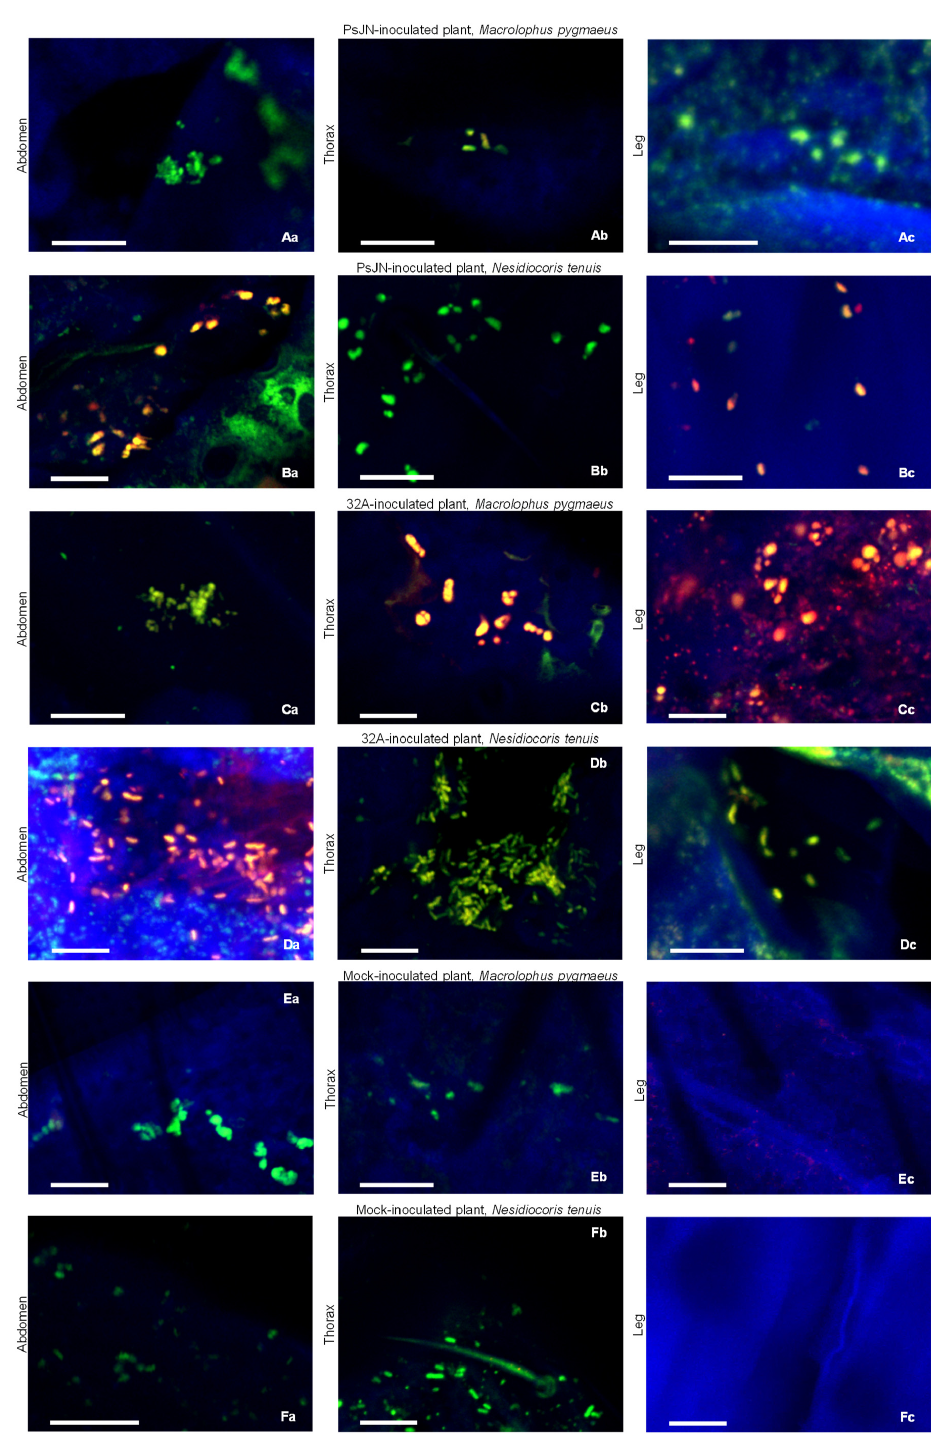
Figure 2. Location of endophytic bacterial strains on mirids. Macrolophus pygmaeus ( A , C , E ) and Nesidiocoris tenuis ( B , D , F ) abdomen ( a ), thorax ( b ) and leg ( c ) samples were collected at the end of the acquisition period (Day 11) on plants inoculated with Paraburkholderia phytofirmans PsJN (PsJN) ( A , B ) or Enterobacter sp. 32A (32A) ( C , D ) or mock-inoculated plants ( E , F ). PsJN cells were hybridised with the EUBmix and Bphyt probes ( A , B ) and 32A cells were hybridised with the EUBmix and Gam42a probes ( C , D ). Mirids fed on mock-inoculated plants ( E , F ) were hybridised with the EUBmix and Gam42a probes. Five replicates (mirids) were analysed for each treatment and representative pictures were selected. Bars correspond to 10 µ